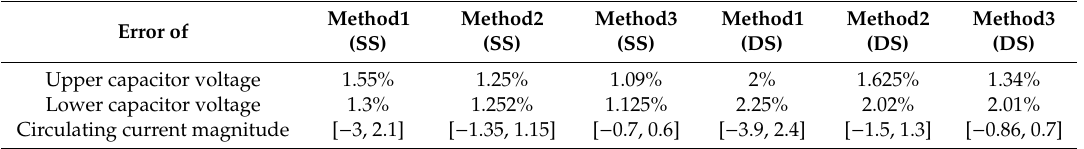
proposed control